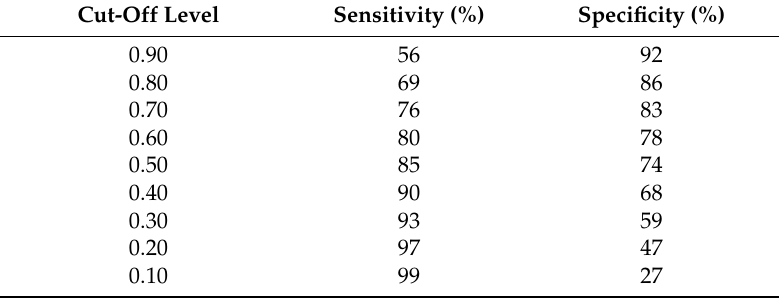
Table 12. Accuracy reached by the fuzzy logic model in terms of sensitivity and specificity at different cut-off